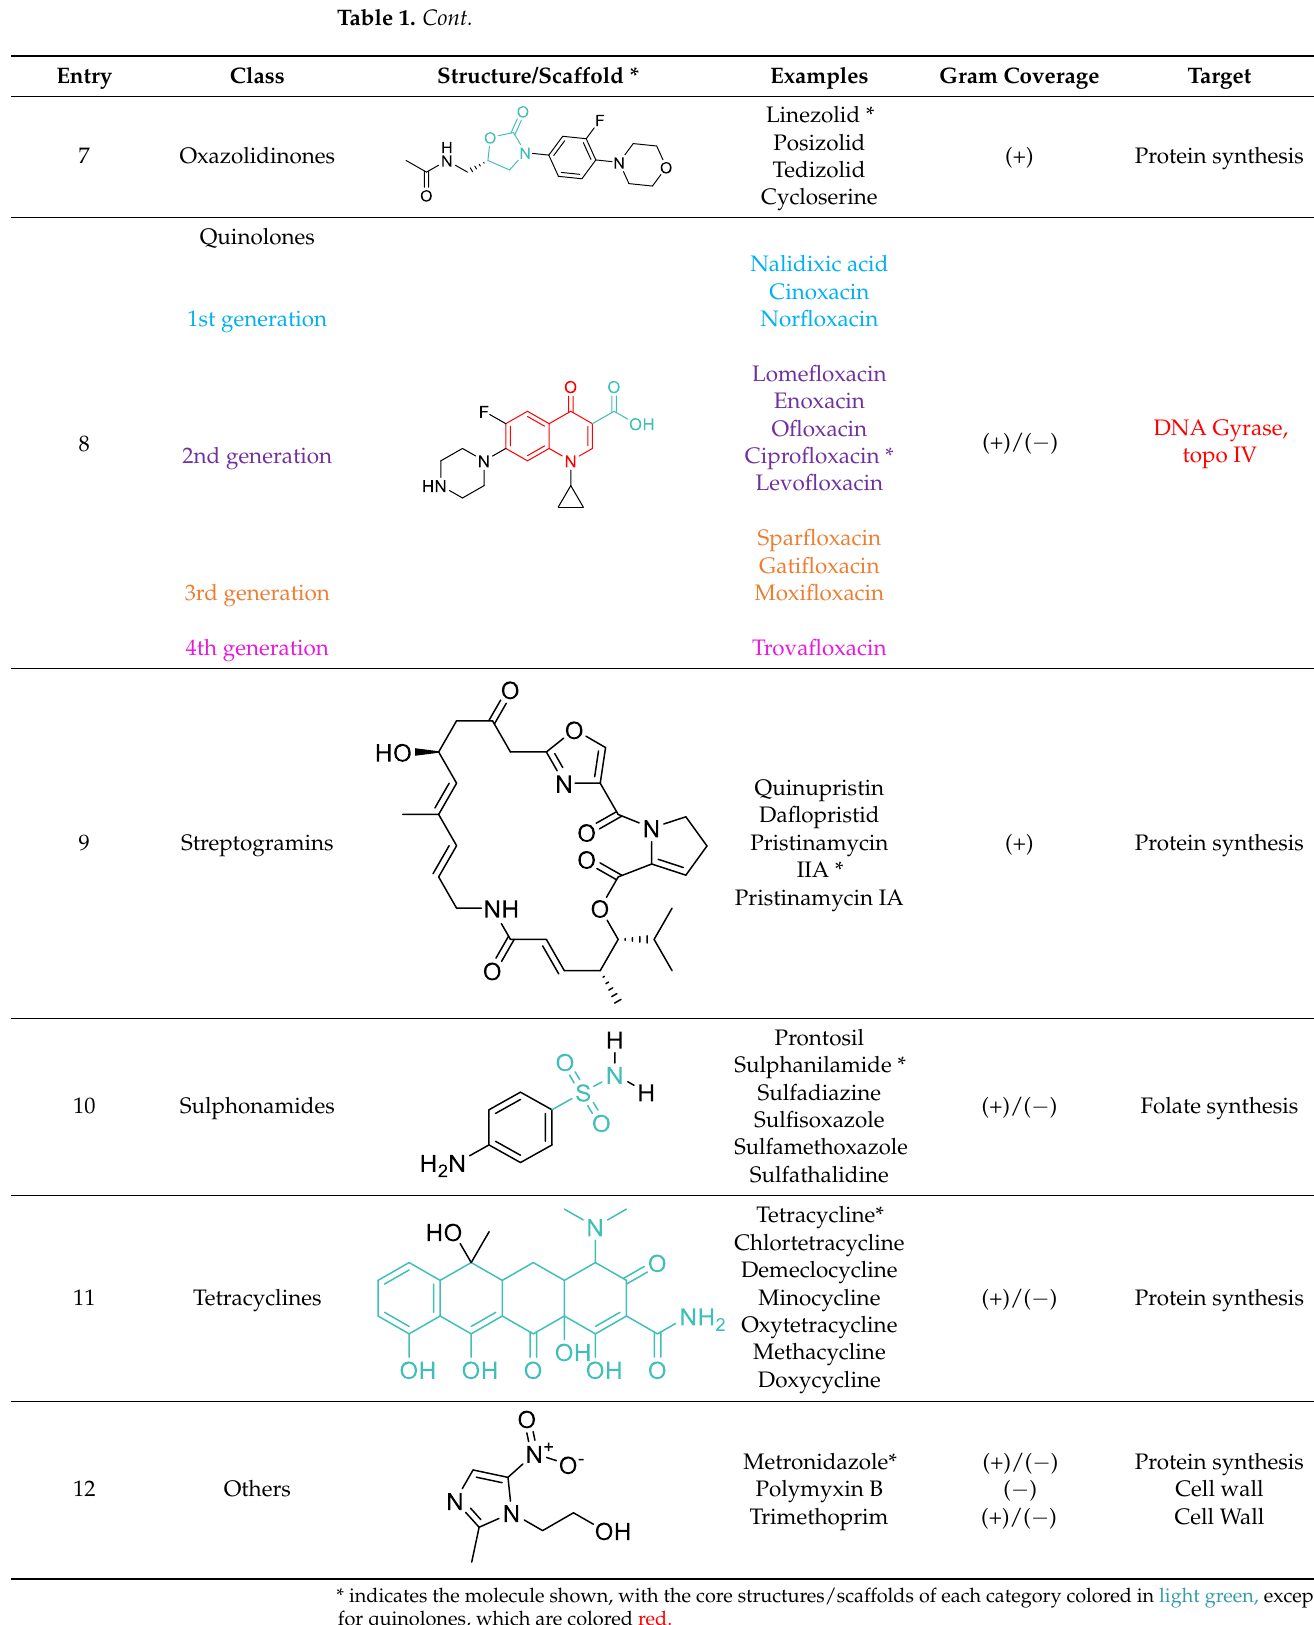
(topo II). Structurally and mechanistically, DNA gyrase and topo IV are similar, however, DNA gyrase is unique in its ability to generate negative supercoils driven by ATP hydrol- ysis [8], while the action of topo IV results in the ATP-driven decatenation of DNA [9]. Topo II action leads to ATP-dependent relaxation of DNA [10]. Drugs that target DNA gyrase and topo IV act to impede the catalytic activity of the topoisomerase enzymes, which, in some cases, can lead to fragmentation of the genome. When these drugs cause potentially lethal double-stranded DNA breaks, they are called topoisomerase poisons. Quinolones are DNA gyrase and topo IV inhibitors, as they im- pair the catalytic activity of the enzymes. In addition, because quinolone action can lead to permanent double-stranded breaks in DNA, in this mode, they are also gyrase poisons, which is the most effective among the modes of action [11 – 15]. In this review, we are fo- cusing on quinolone-based antibacterial agents.